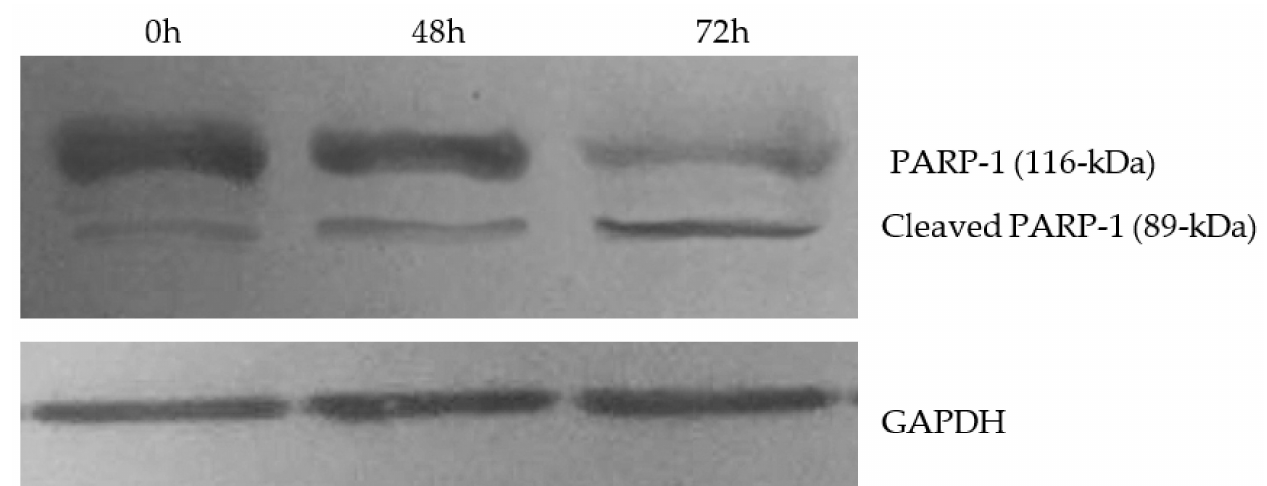
Figure 5. PARP-1 cleavage. A2058 melanoma were treated with compound 2k (used at its IC 50 value) for 48 and 72 h and then the total protein extracts were analyzed by Western blot. PARP-1 native form (116-kDa) and the cleaved form (89 kDa) were visualized. Time points 0 h, 48 h and 72 h for protein extraction. GAPDH was used for loading normalization. Blots are representative of three independent